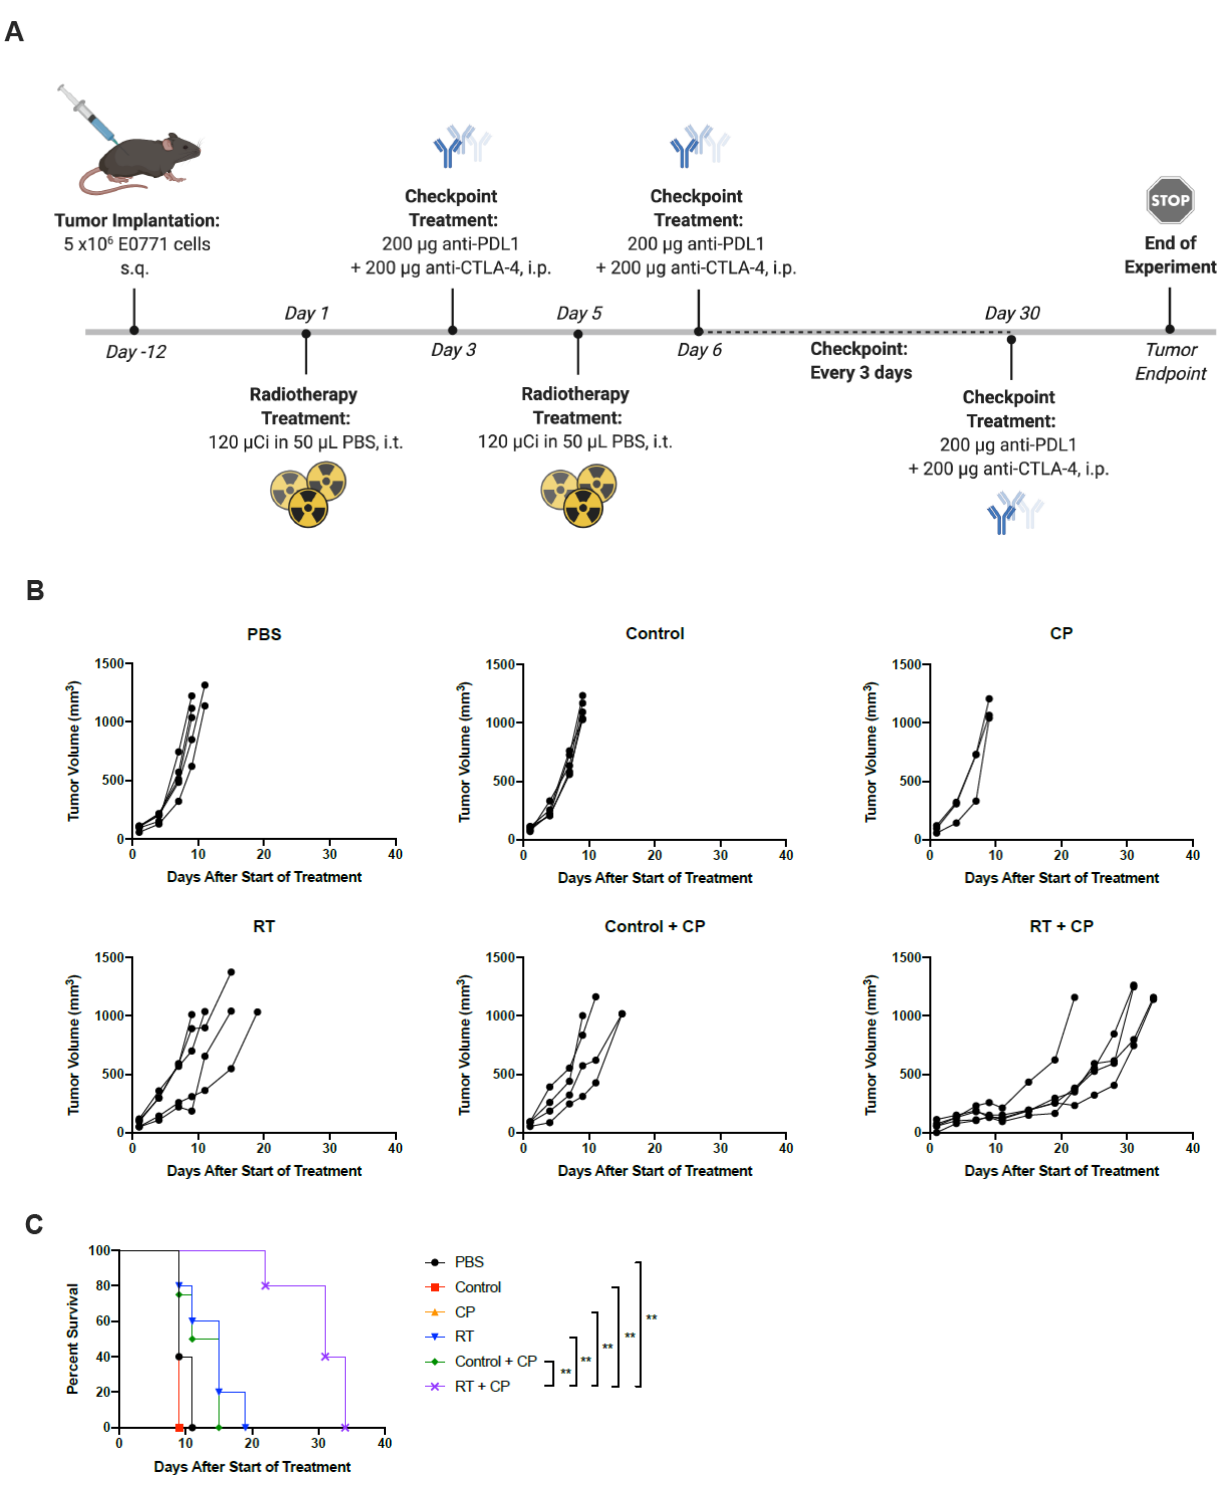
Figure 6. RT + CP significantly improves overall survival. ( A ) C57/Bl6 mice bearing E0771 tumors were treated with PBS, control, CP (anti-CTLA4 and anti-PD-L1), RT, control + CP or RT + CP. *Created using BioRender.com. ( B ) Tumor volumes were measured every 2 – 3 days from the start of treatment until mice reached endpoint. Each line represents an individual mouse within the group. ( C ) Kaplan – Meier survival curves of each group. ** p < 0.001.